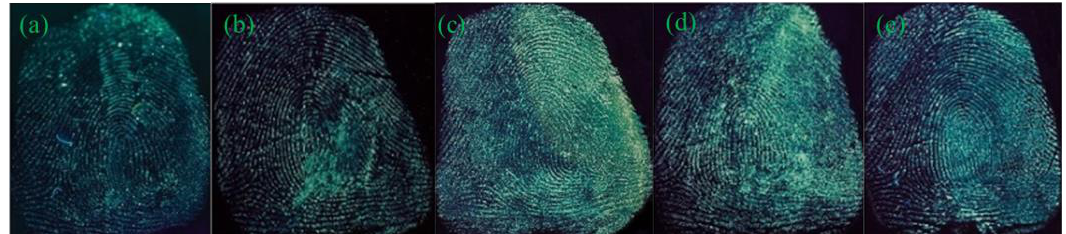
Figure 4. Fingermarks developed by G-CDs with different pH values. ( a ) pH = 6; ( b ) pH = 8; ( c ) pH = 9; ( d ) pH = 10; ( e ) pH = 12.